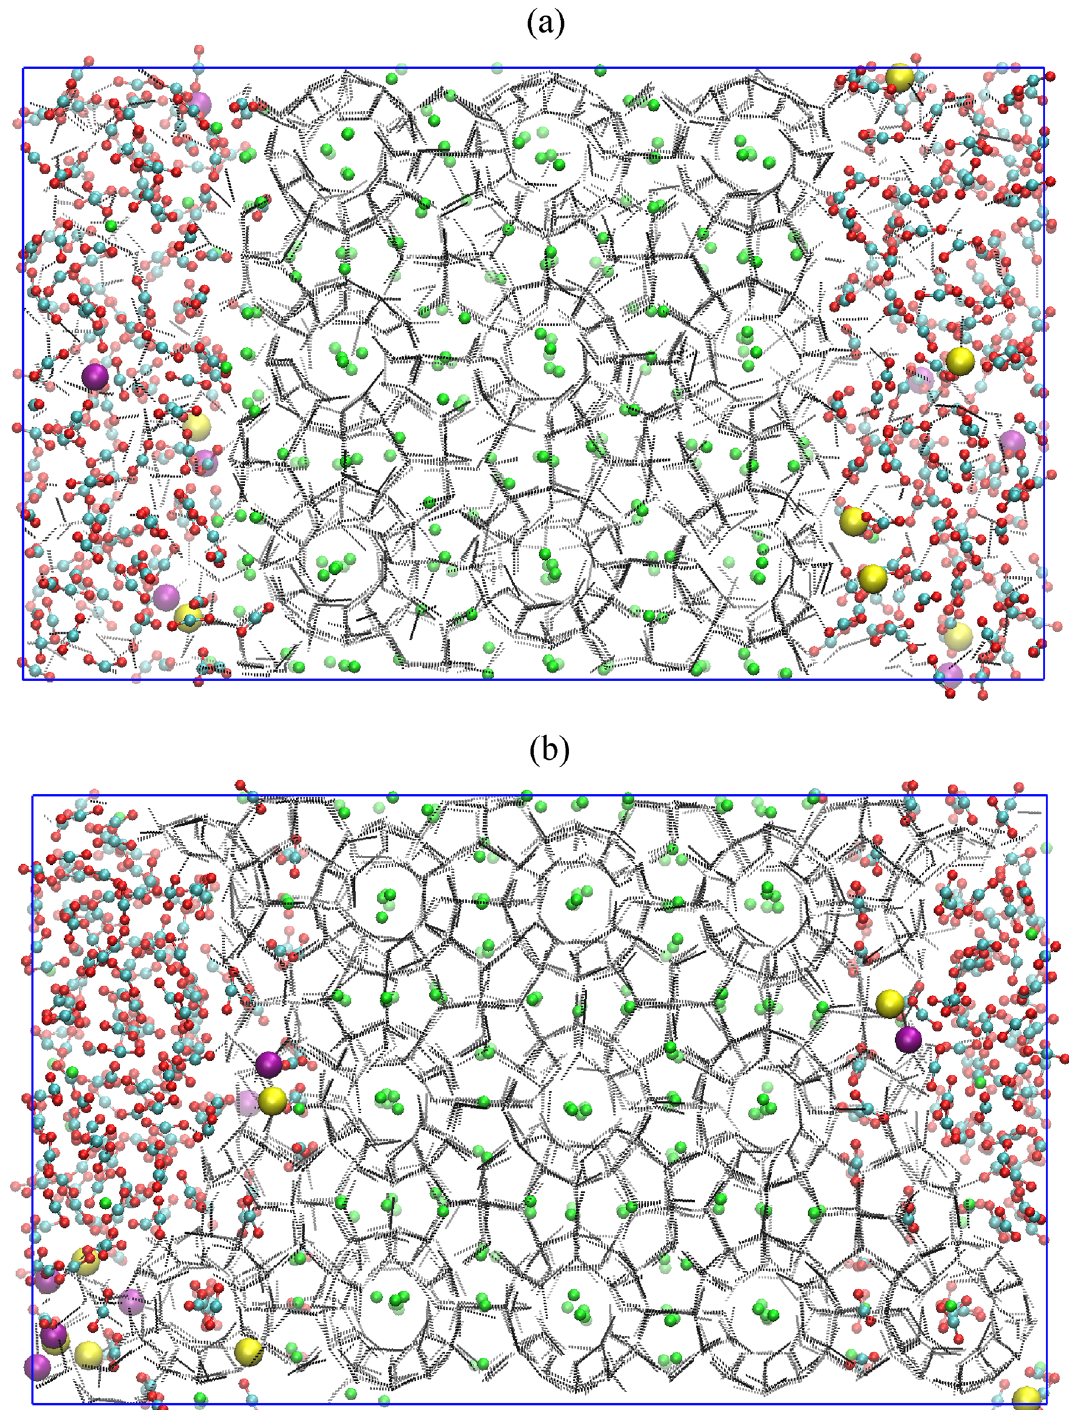
Figure 8. Screenshot of the CH 4 –CO 2 replacement dynamics in presence of free water molecules, carbon dioxide and salt ions with operating conditions of 260 K and 50 MPa at ( a ) 0 µs and ( b ) 2 µs. The atoms of sodium and chlorine ions are represented by purple and yellow spheres, respectively. The water molecules are defined by TIP4P-Ice